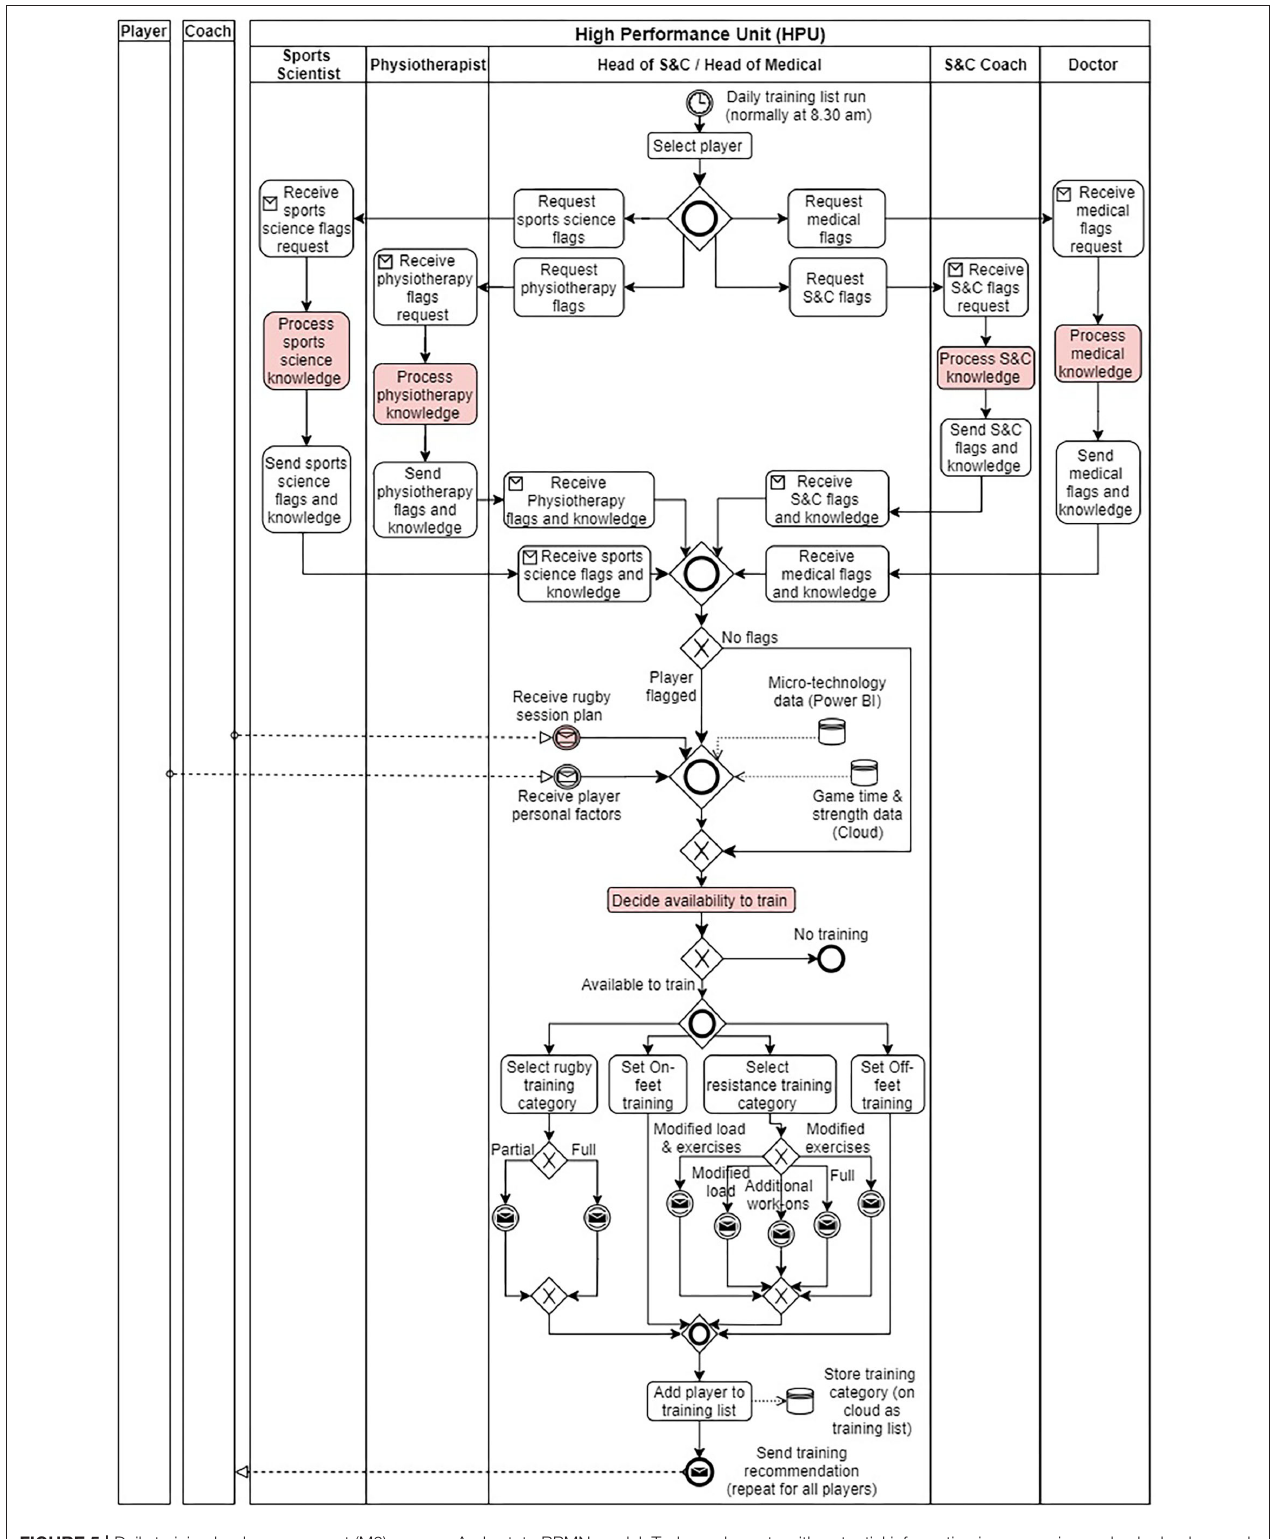
FIGURE 5 | Daily training load management (M2) process As-Is state BPMN model. Tasks and events with potential information issues are in a red color background (discussed under Process Analysis).